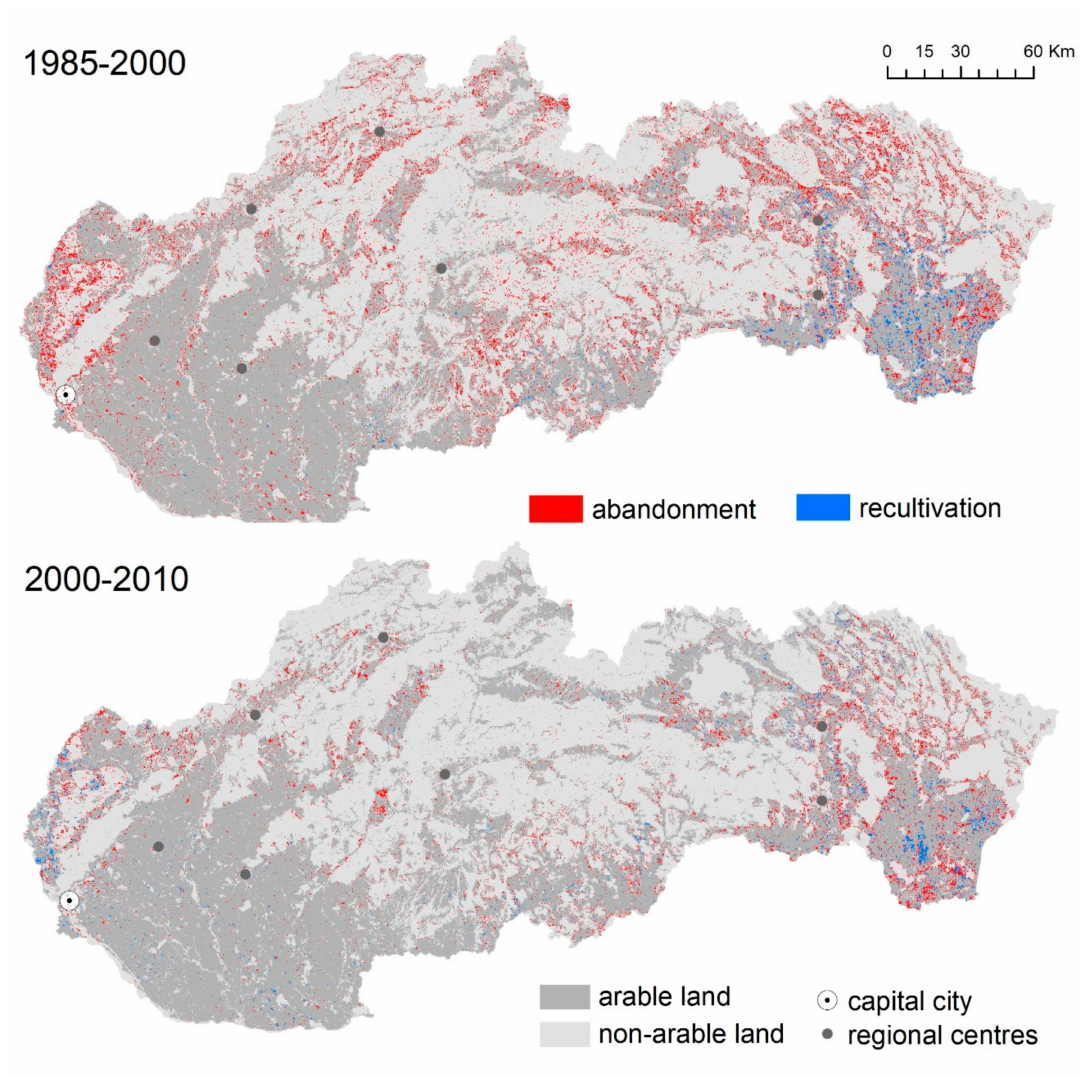
Figure 3. Agricultural land use change in Slovakia for 1985–2000 and 2000–2010. Source: